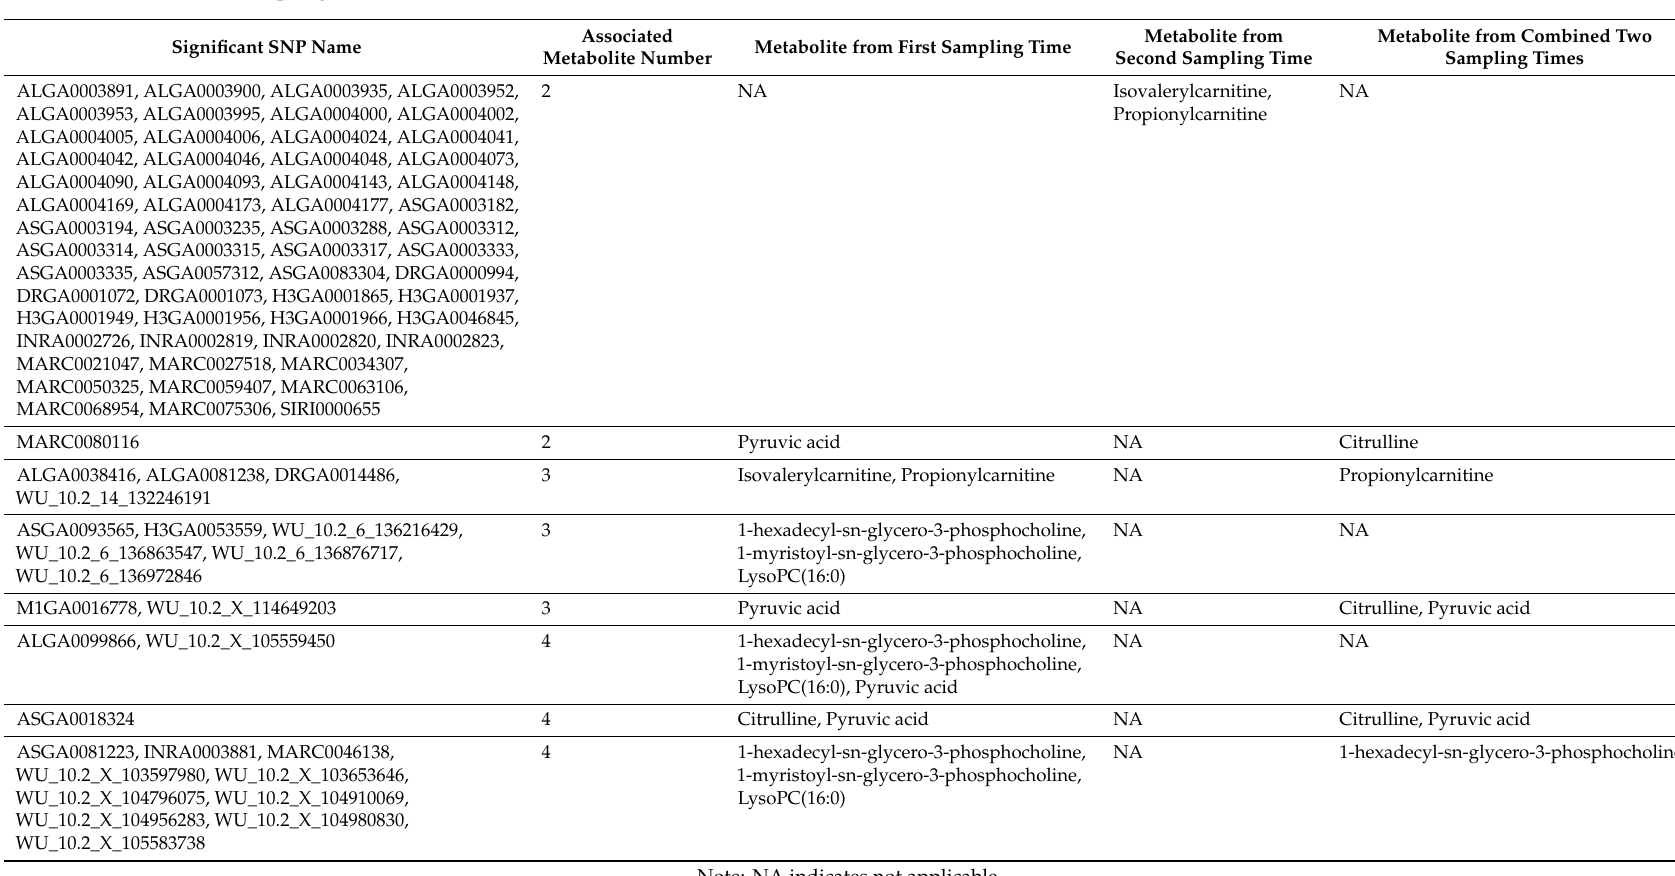
Table 2. Common significant single-nucleotide polymorphisms (SNPs) of genome-wide association for more than two di ff erent metabolites from first, second, and combined two sampling